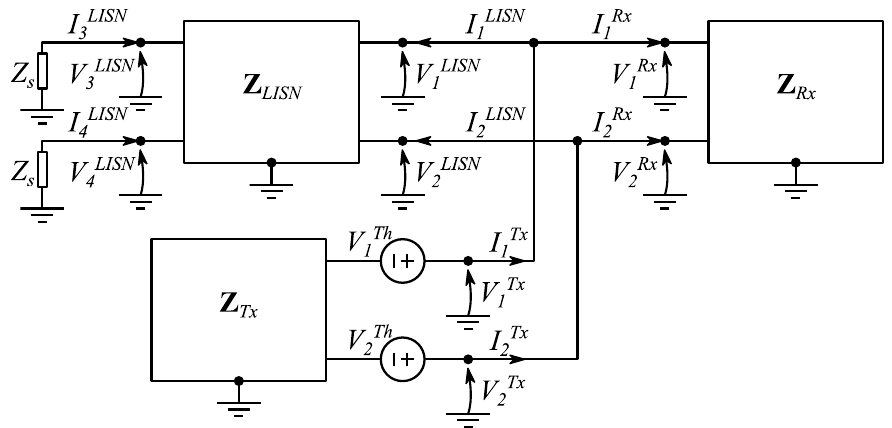
Figure 5. Characterization of the two LISNs as a four-port network.